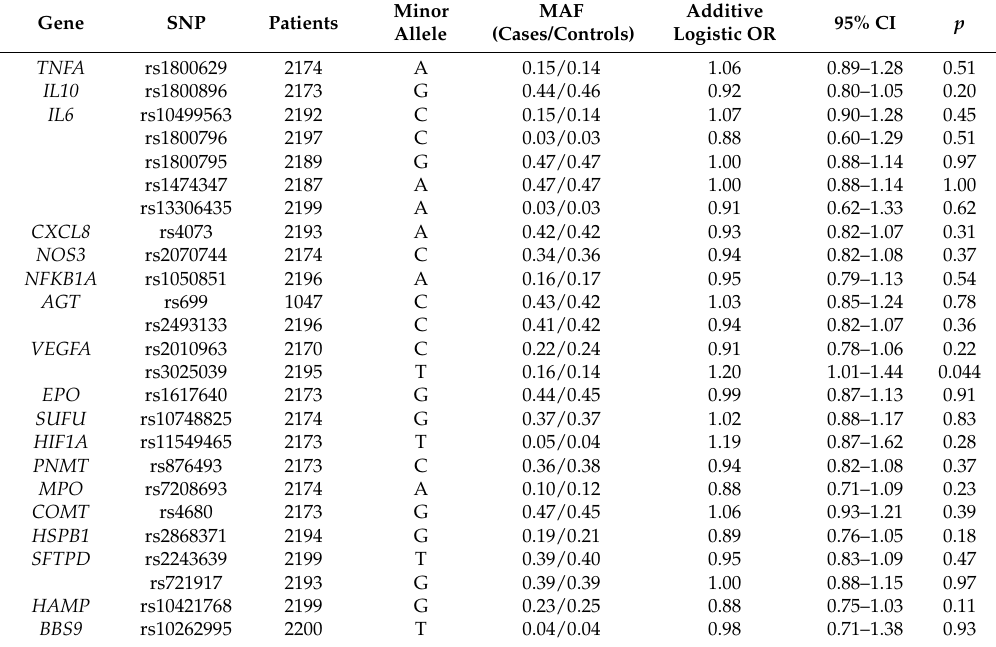
Table 2. Association of genetic variants with acute kidney injury (AKI) KDIGO stages 2 and 3 compared to stage 0. Odds ratios (OR) and confidence intervals (95% CI) are reported for each copy of minor allele.